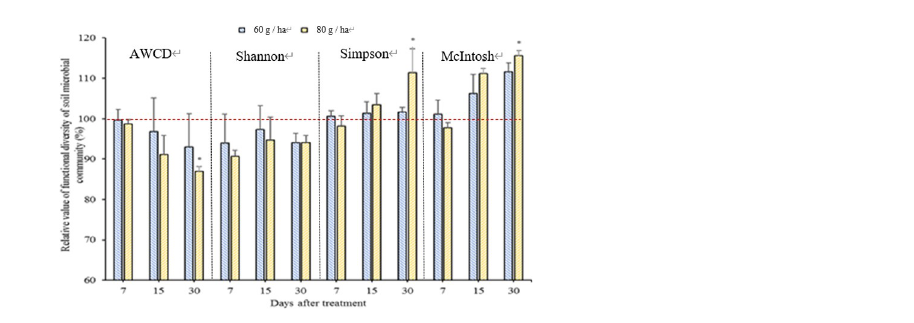
Fig 3. Corrected RKN mortality of fluopyram applied by chemigation under the most effective parameters on root-knot nematodes in a two-time field experiment. The blue figure represents the corrected RKN mortality in field experiments in May, 2018; the orange figure represents the corrected RKN mortality in the adjacent experimental field in August, 2018.